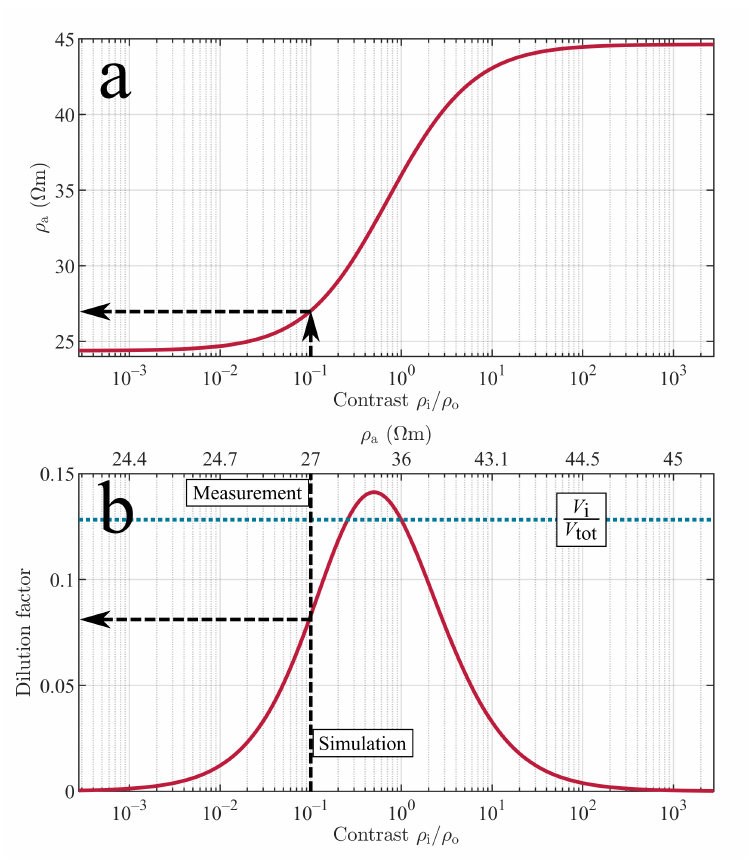
Figure 4. ( a ) Bulk resistivity ρ a vs. resistivity contrast between the sample and outer medium obtained by numerical simulation. The simulation was carried out for one specific sample geometry with r = 1.3 cm and l = 3.876 cm. The resistivity of the outer medium was fixed to 36 Ω m, as obtained from an experiment with the saturated sand. The dashed arrows illustrate the estimation of ρ i from a measured ρ a . ( b ) Dilution factor vs. resistivity contrast obtained from numerical simulation. The top horizontal axis is the bulk resistivity ρ a obtained for each resistivity contrast. The dashed arrows illustrate the correspondence between the measured ρ a (in this case 27 Ω m) and the dilution